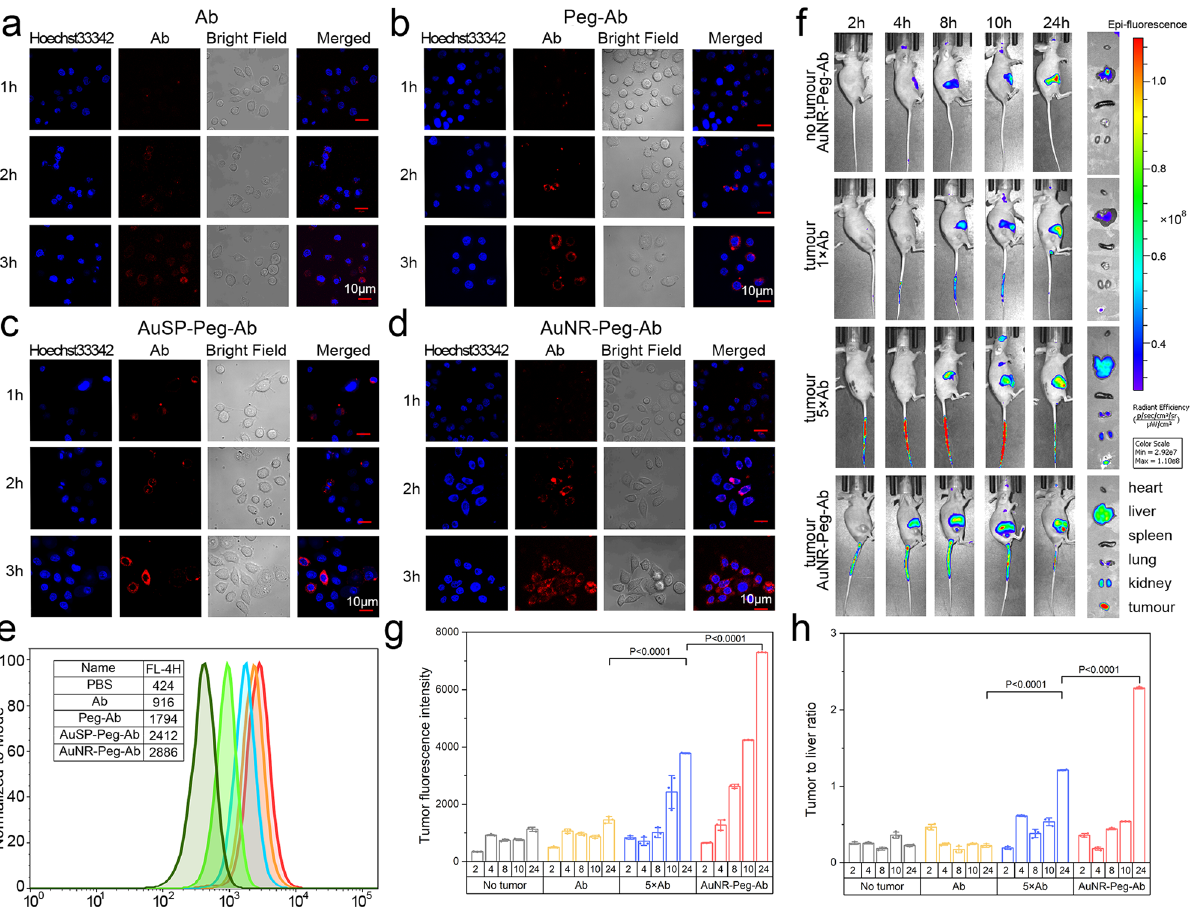
Fig. 3 Tumor-targeting capability of Ab and Au-PEG-Ab. a – d Representative immuno fl uorescence images of a Ramucirumab (Ab), b Ab linked to PEG, c , d Gold nanoparticles (AuSP and AuNR) linked Ab treated SNU5 cells. e Flow cytometry analysis of nanoparticles cellular uptake ef fi ciency. f – h In vivo imaging of the gold nanomaterial in the SNU5 tumor bearing mice. f Images of tissue and major organs at different time periods after intravenous injection of Ab and AuNR-PEG-Ab. g , h fl uorescent intensity (F tumor ) and F ratio (F tumor to F Liver ratio) measurement at different time. Data represent mean ± SD ( n = 3). Statistical difference was evaluated by one-way ANOVA followed by Tukey ’ s post hoc